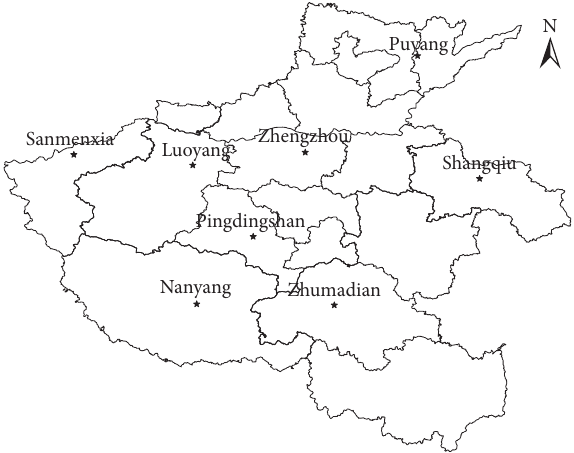
Figure 1: Distribution of 8 radars in Henan